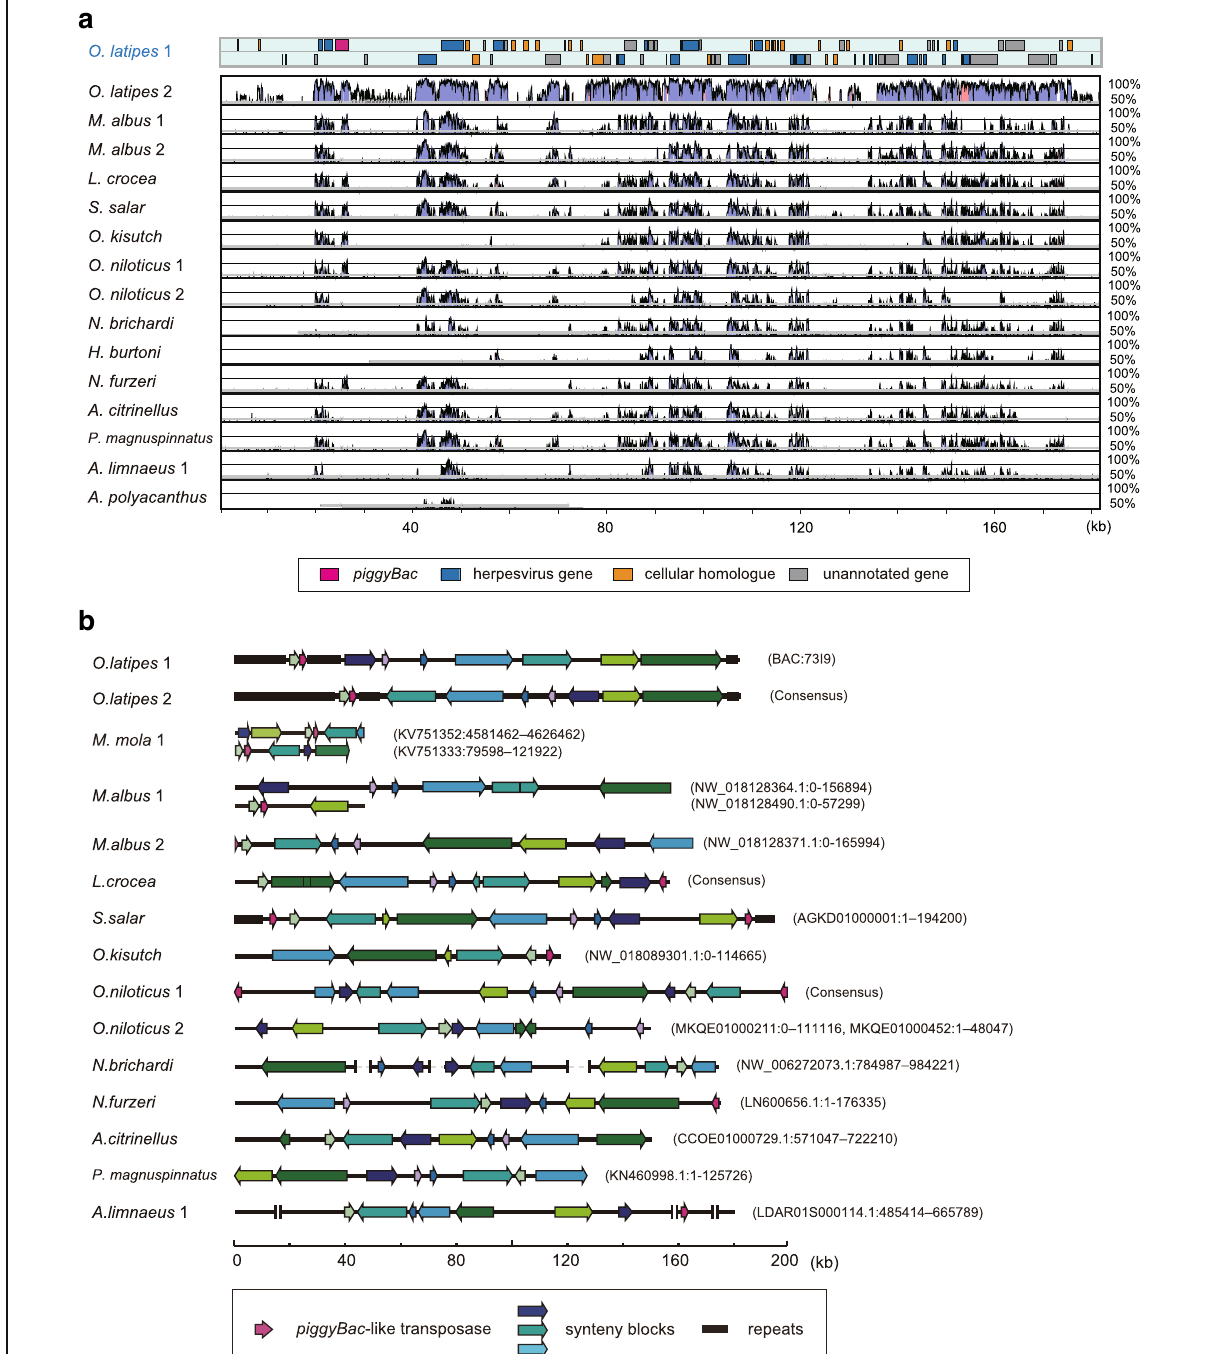
Fig. 2 Teratorn -like viruses encode a series of herpesvirus genes a A homology plot of Teratorn -like virus sequences compared to medaka Teratorn subtype 1, visualized by VISTA. Blue and white regions indicate coding and non-coding regions, respectively. Colored boxes in the two bars above the histograms indicate the positions of forward- and reverse-oriented predicted genes of medaka Teratorn subtype 1 (magenta, piggyBac -like transposase gene; blue, herpesvirus-like genes; orange, cellular homologs; gray, unannotated genes). All sequences displayed in this plot are the same as those in ( b ). b Structures of Teratorn -like viruses in several teleost fish species. Conserved synteny blocks are depicted by arrows of the same color. Magenta arrows indicate the piggyBac -like transposase gene. Sources of each sequence are described on the right. These sequences were (1) extracted from contigs or scaffolds ( M. mola , M. albus , S. salar , O. kisutch , N. brichardi , N. furzeri , A. citrinellus , A. limnaeus and A. polyacanthus ), or (2) reconstructed by conjugating multiple contigs (subtype 2 Teratorn of O. latipes , L. crocea and O. niloticus ) or BAC sequencing (subtype 1 Teratorn of O. latipes